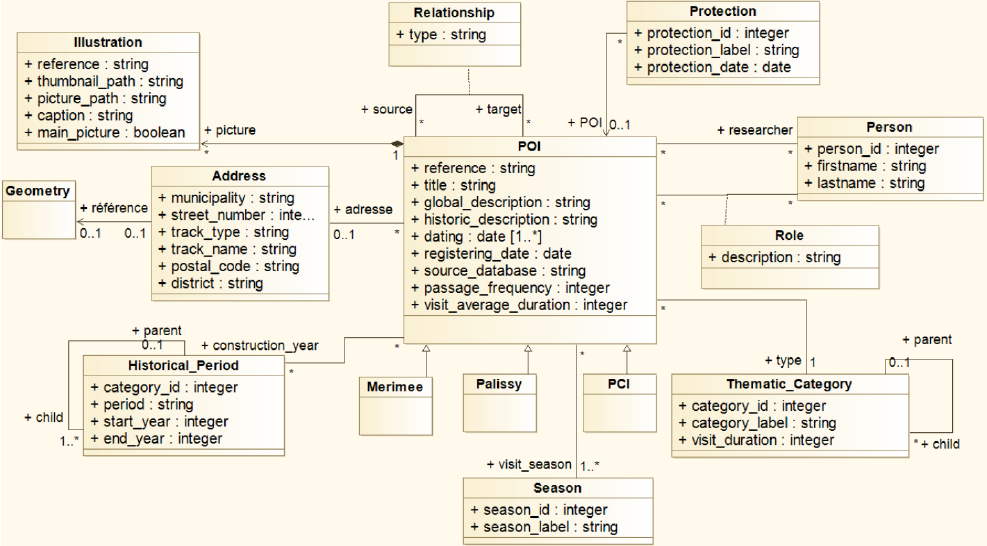
Figure 2. Unified cultural heritage point of interest (POI) data